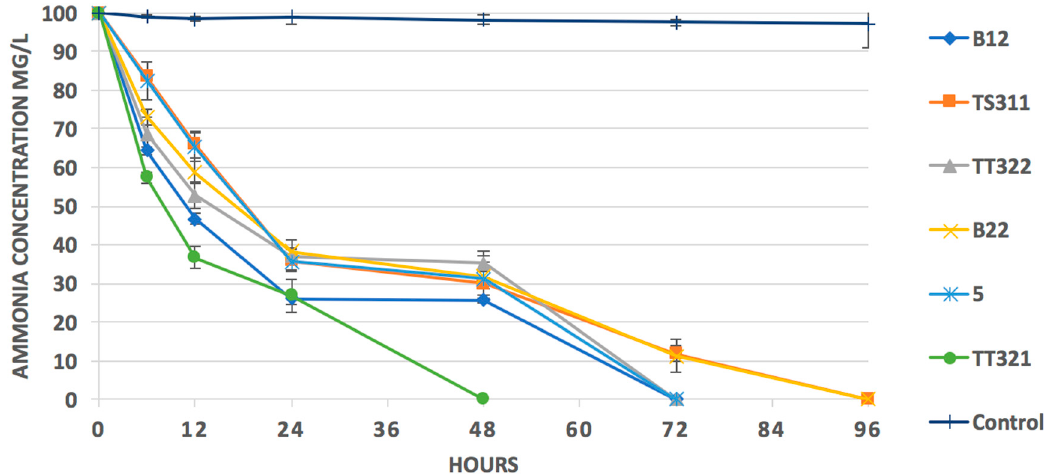
Figure 4. Changes in concentrations of N-NH 4 + in the culture medium during the heterotrophic nitrification test. Six strains (B12, B22, 5, TS311, TT321, and TT322) were isolated from three water samples of L. vannamei.